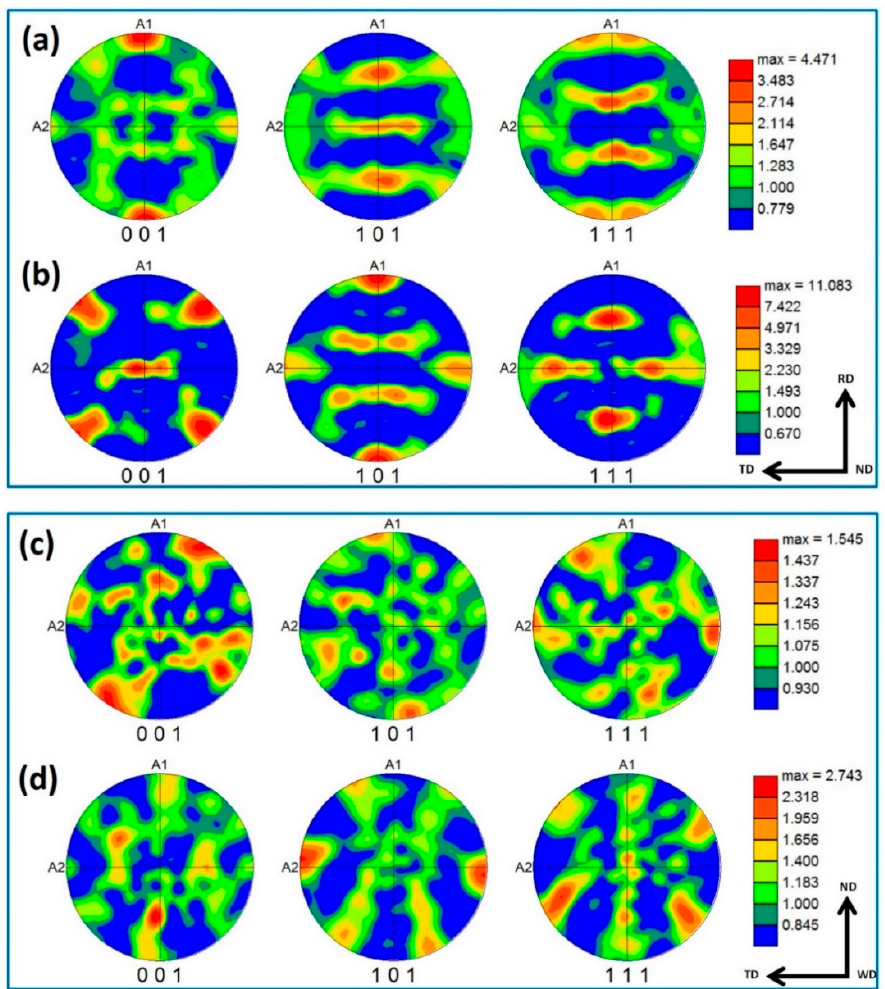
Figure 16. 001, 101, and 111 pole figures of BM ( a ) austenite, ( b ) ferrite and NG of FSWed joint ( c ) austenite, ( d ) ferrite.